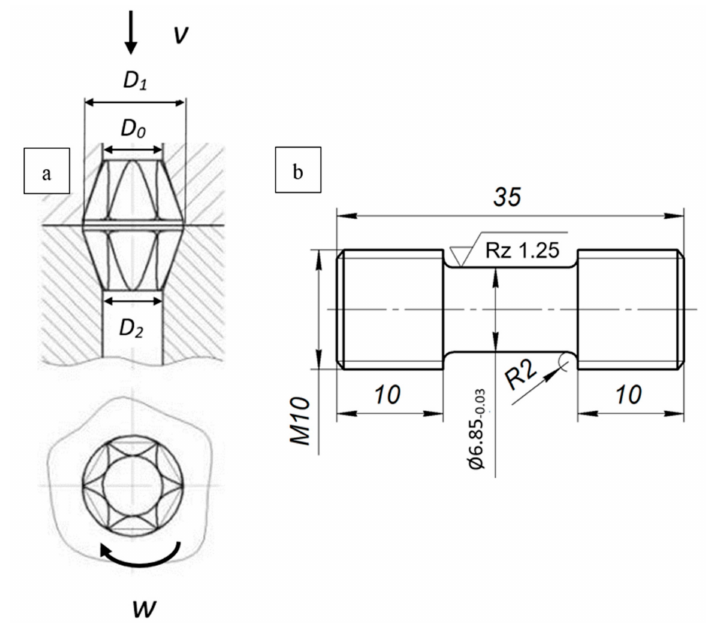
Figure 2. HPTE die with ( a ) holding elements and ( b ) a schematic drawing of the tensile test sample. Dimensions are given in